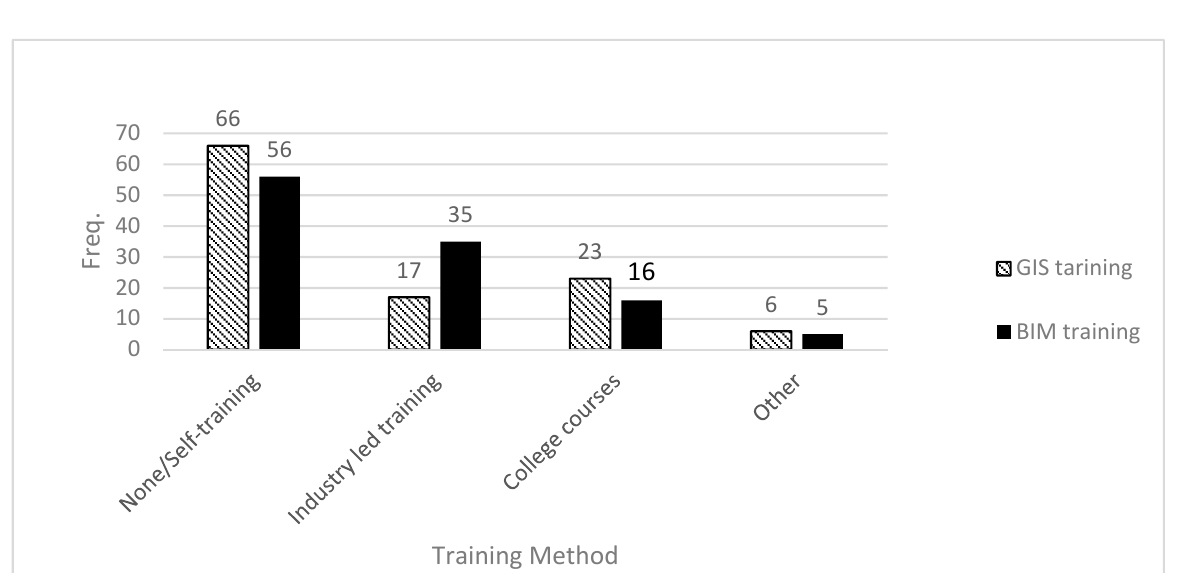
Figure 4. BIM and GIS Training Method.